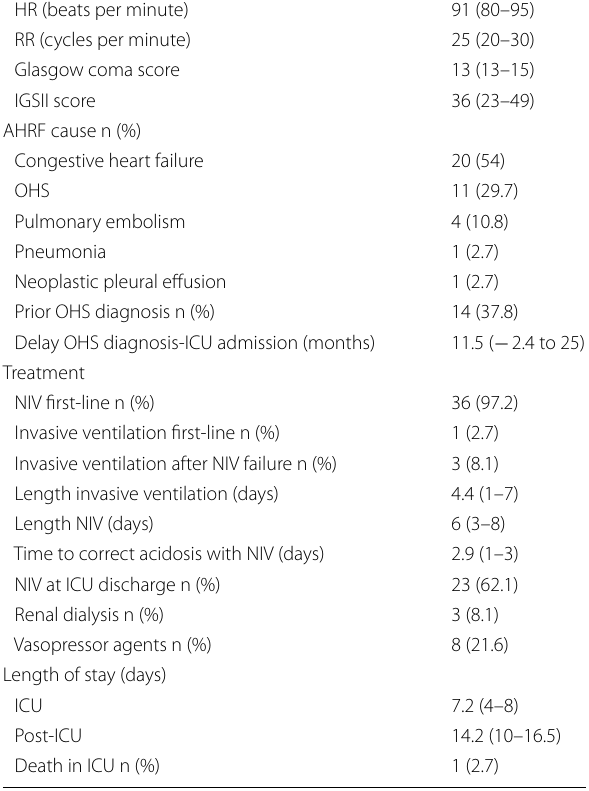
Table 1. Clinical, biological and treatment characteristics of patients with OHS admitted to the ICU